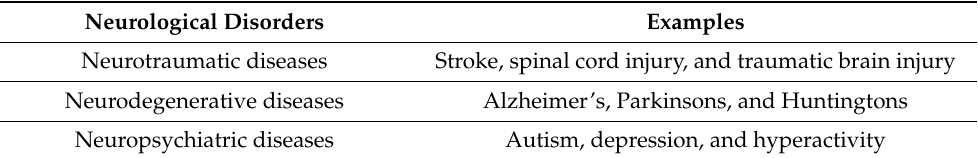
Table 4. Classification of neurological diseases